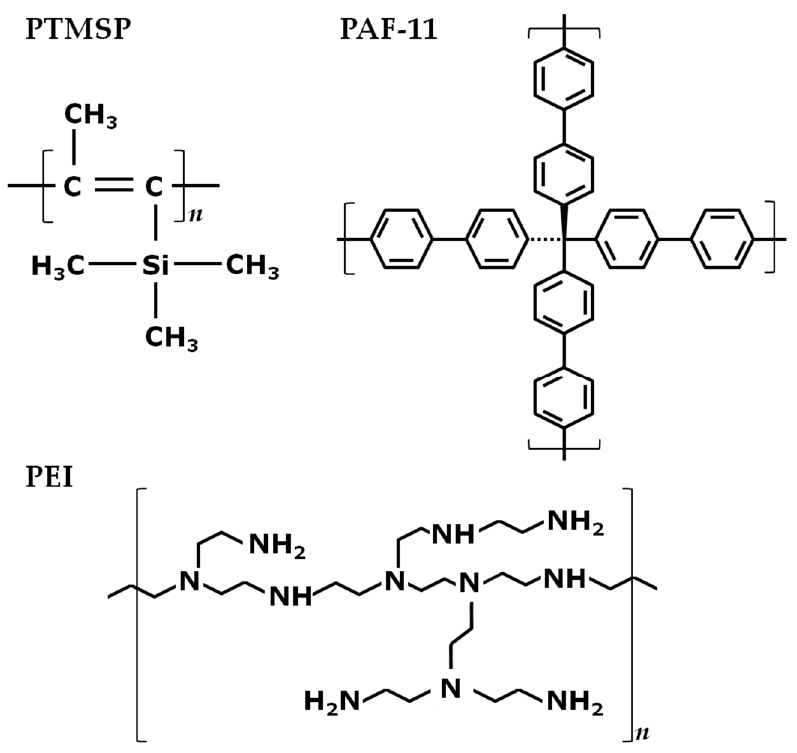
Figure 1. Chemical structure of polymers poly(1-trimethylsilyl-1-propyne), branched polyethylene- imine, and porous aromatic framework PAF-11.